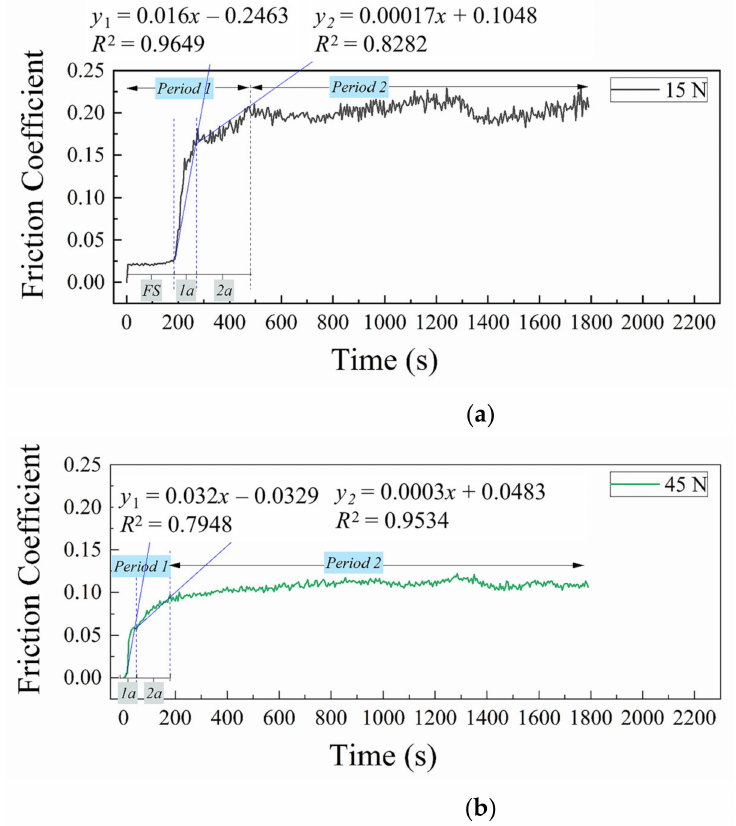
Figure 8. Analysis on the instantaneous friction coefficient slopes for the tribo-pair working under different loads: ( a ) 15 N; ( b ) 45